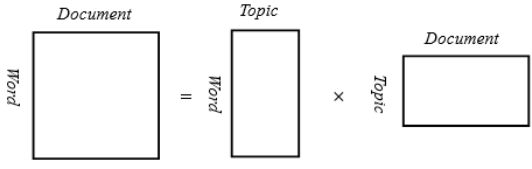
Figure 3. An abstract representation of LDA principle.